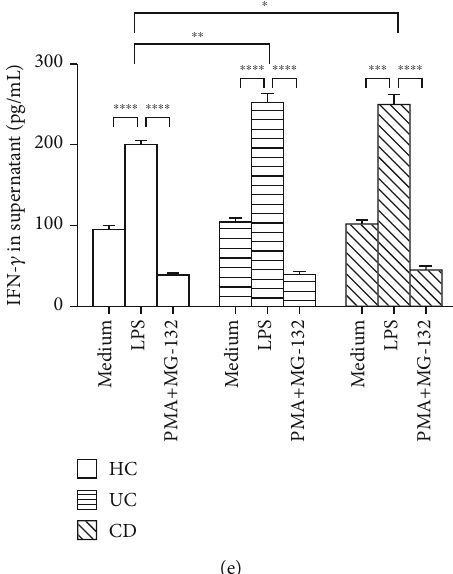
Figure 5: MCPIP-1 degrades the protein levels of proin fl ammatory cytokine in neutrophils. Peripheral neutrophils ( 2 × 10 6 ) were isolated from patients with active CD ( n = 10 ), active UC ( n = 10 ), and HC ( n = 10 ) and stimulated in vitro with LPS (200ng/mL) in the absence or presence of MG-132 (20 μ M) for 3 hours as indicated in Figure 4. Culture medium was replenished, and cells were incubated for another 24 hours. Supernatants were then harvested, and protein levels of IL-1 β (a), IL-6 (b), TNF- α (c), IL-8 (d), and IFN- γ (e) were measured by ELISA. ∗ P < 0 : 05 , ∗∗ P < 0 : 01 , ∗∗∗ P < 0 : 001 , and ∗∗∗∗ P < 0 : 0001 .